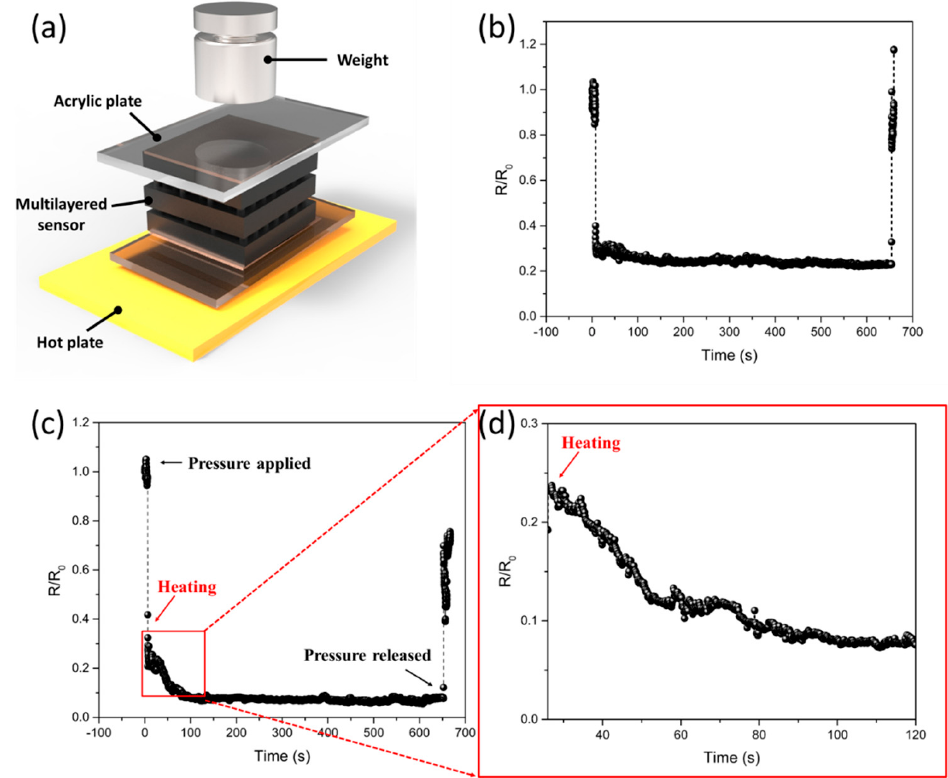
Figure 7. Piezoresistive pressure-temperature sensing performances of multilayer sensor with modulus gradient ( a ) Schematic of the multilayer sensor for detecting pressure and temperature changes ( b ) Real-time monitoring of pressure (mass 100 g) by multilayer sensor ( c ) Real-time monitoring of relative resistance changes under pressure (100 g), and ( d ) expanded signal showing the temperature response of the multilayer sensor (25–40 °C).